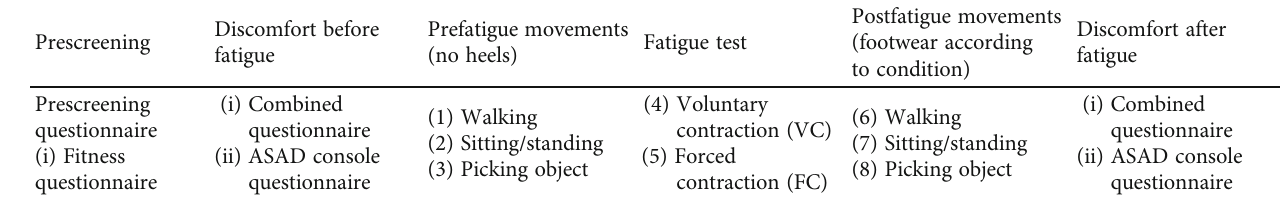
Table 2: Experimental procedure.